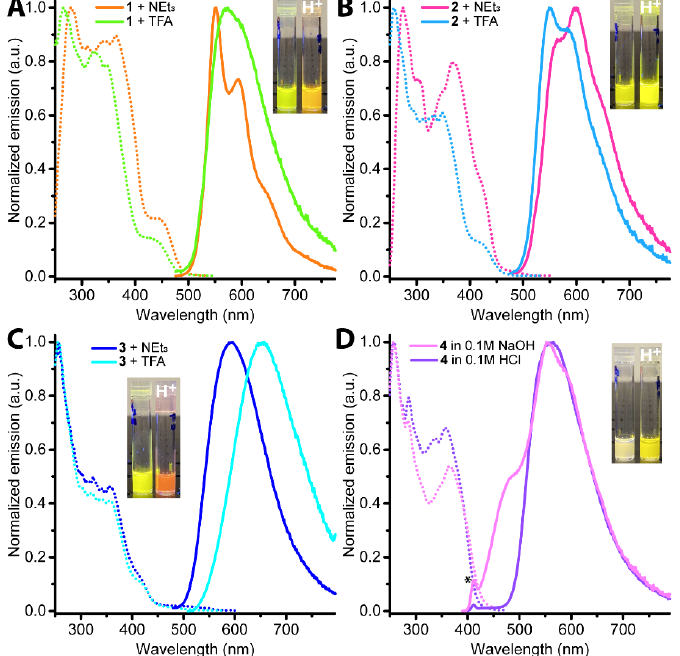
Figure 3. Normalized excitation (dashed line) and emission (solid line) spectra of 1 – 4 ( A – D respec- tively). Emission spectra were recorded under excitation at 360 nm, excitation spectra were recorded at emission band maxima, dichloromethane, 1 × 10 − 5 M. A weak emission at 410 nm is generated by solvent (water) Raman resonance signal (*).